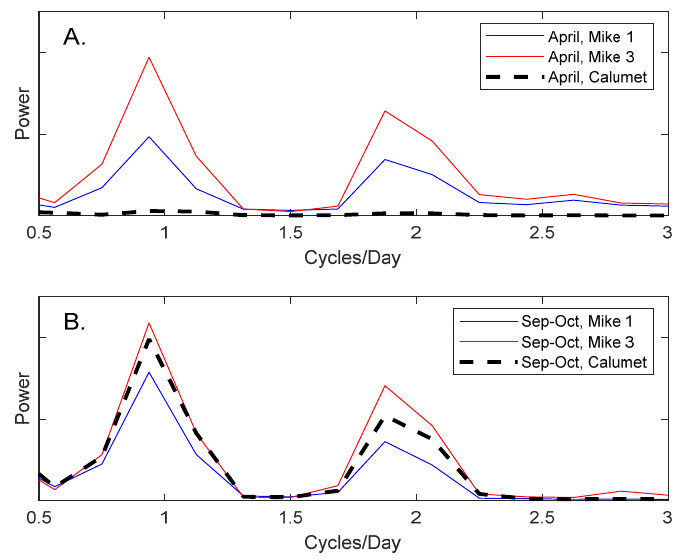
Figure 8. Water level cycles / day at the Calumet (dashed black), Mike1 (blue) and Mike3 (red) sampling stations in April ( A ) and September–October ( B ) 2015. Tidal cycles at the Calumet station are barely detected in April due to spring river flood dominance.